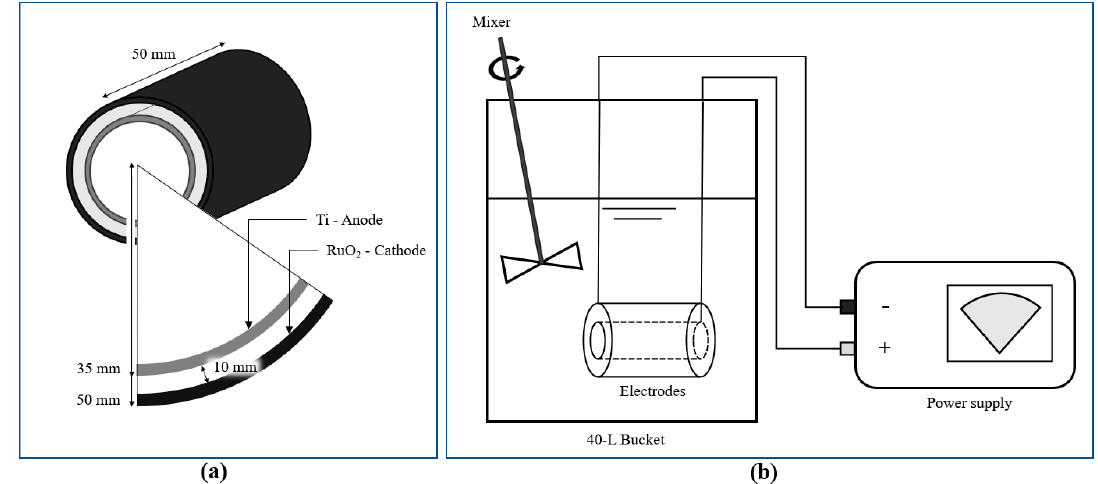
Figure 1. Electrodes and batch experiment set-up. ( a ) Two cylindrical electrodes used in this study. ( b ) Batch experiment set-up for kinetic tests.